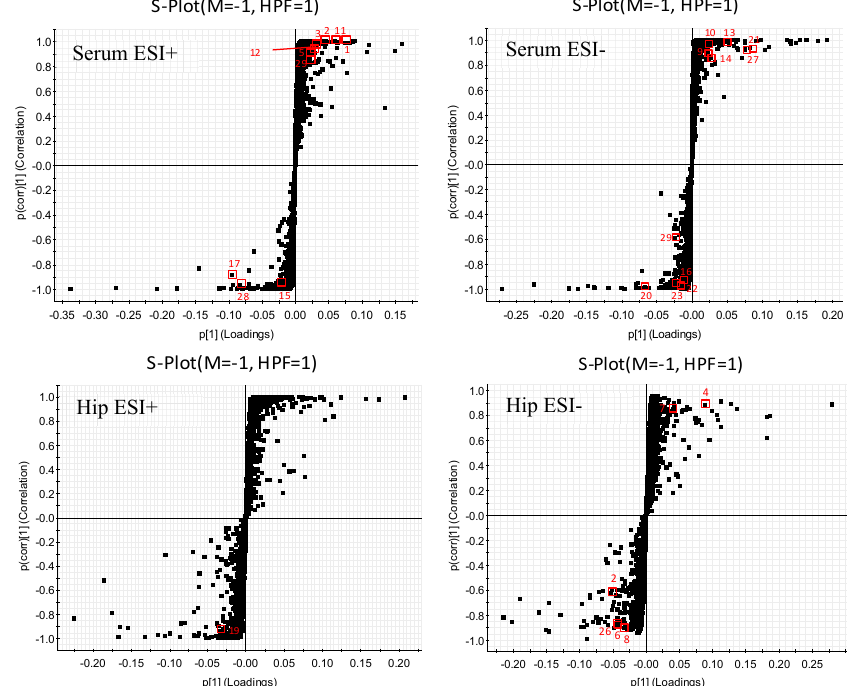
Figure 8. OPLS-DA S -plots of serum and hippocampus metabolic profiling. (Numbers marked are Figure 8. OPLS-DA S- plots of serum and hippocampus metabolic profiling. (Numbers marked are consistent with the No. of each biomarker in Table consistent with the No. of each biomarker in Table 1).